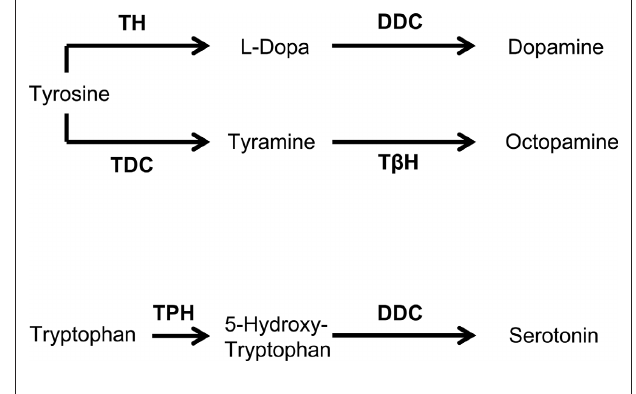
FiGuRe 2 | Biosynthesis of dopamine, tyramine, octopamine, and serotonin. DDC, dopa decarboxylase; T β H, tyramine β -hydroxylase; TDC, tyrosine decarboxylase; TH, tyrosine hydroxylase; TPH, tryptophan hydroxylase. Modified from Monastirioti